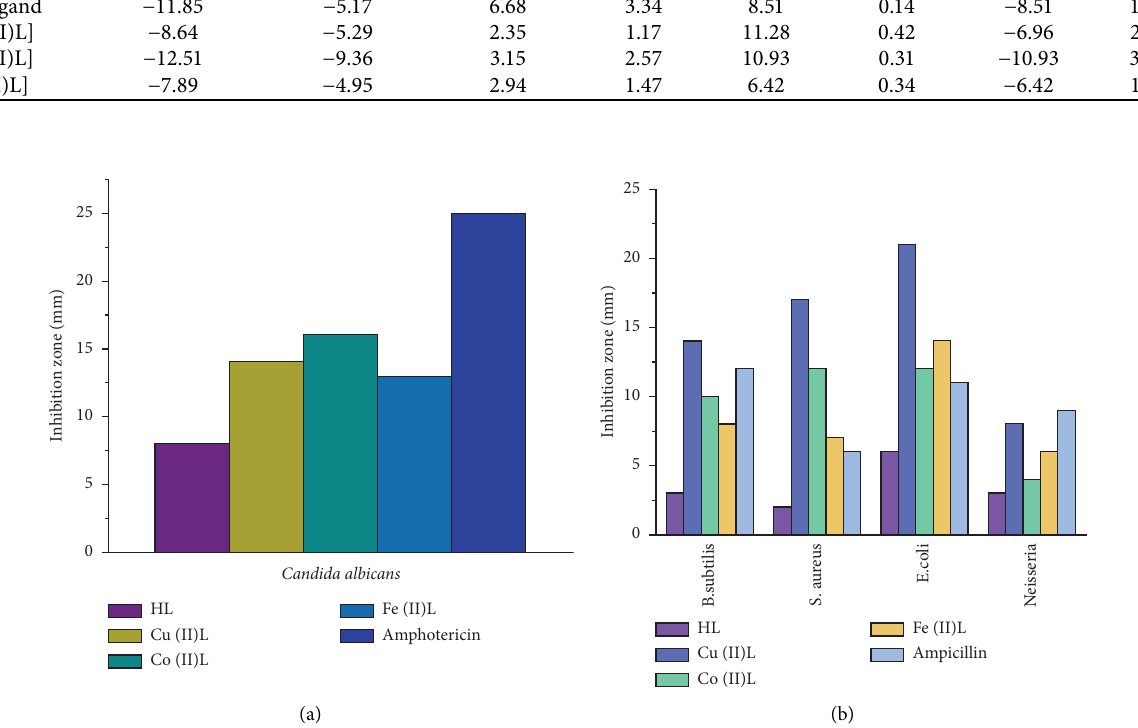
Table 5: E HOMO , E LUMO , E gap , and quantum parameters for the HL ligand and its complexes. Compound